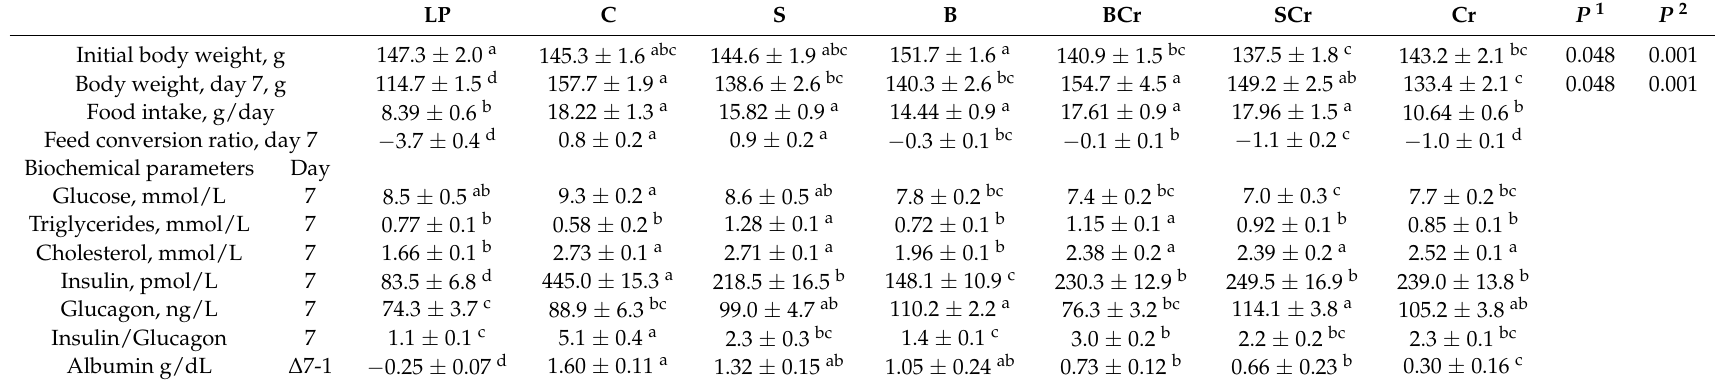
Table 3. Biochemical, anthropometric variables and feed conversion ratio of Sprague-Dawley rats fed different types of protein after a protein-restricted